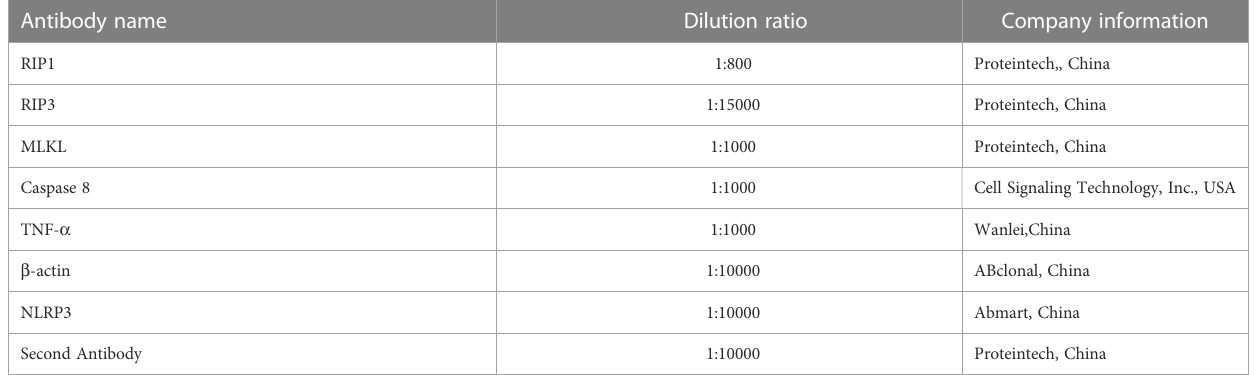
TABLE 2 The antibodies used in the present